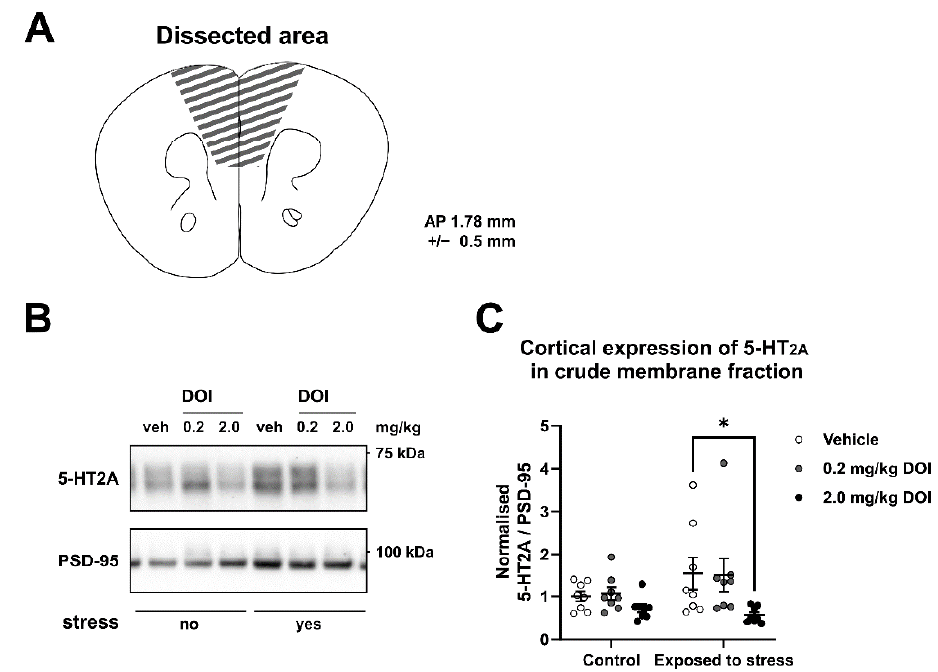
Figure 3. Effects of DOI administration on 5-HT 2A /PSD-95 ratio in a crude membrane fraction of the mouse mPFC. ( A ) Representation of a target area. ( B ) Representative western blot results for the 5-HT 2A receptor and PSD-95 signal. ( C ) Quantification of 5-HT 2A /PSD-95 signal ratio, normalized to control vehicle group. Data are represented as mean values +/ − SEM. * p < 0.05 vs. Veh group.